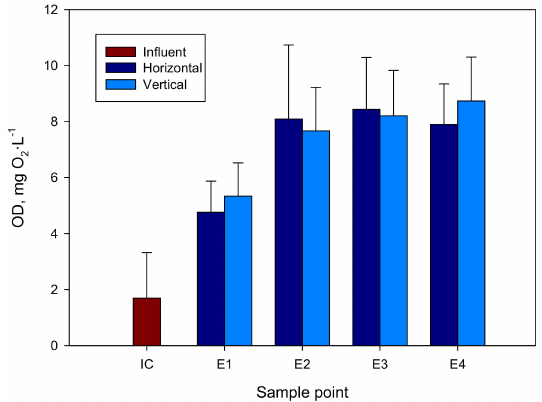
Figure 5. Evolution of the dissolved oxygen along the treatment in the two pilot